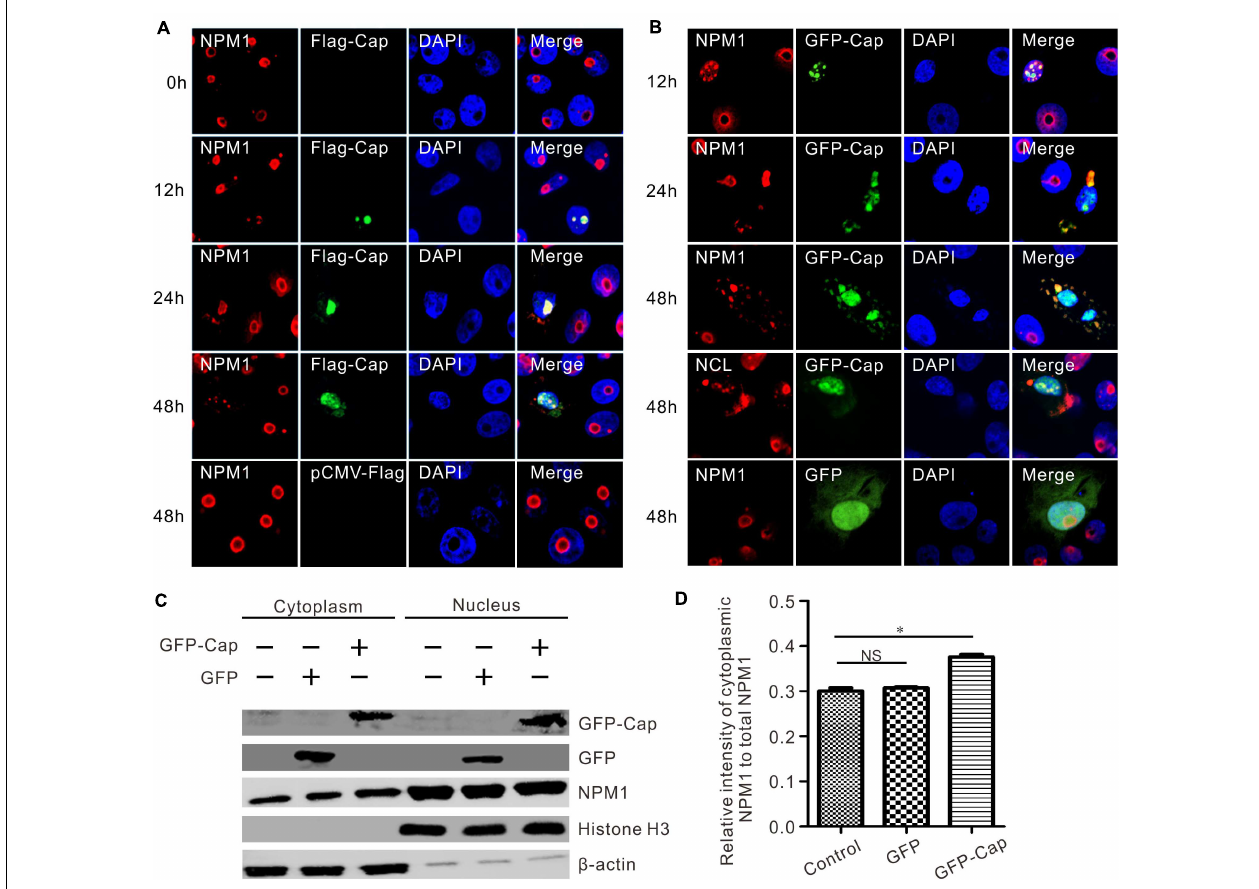
FIGURE 4 | Endogenous colocalization analysis. PCV3 Cap induced the translocation of NPM1 to the cytoplasm from the nucleus. (A,B) PK15 cells were transfected to express FLAG-Cap and GFP-Cap. The cells were incubated with the antibodies corresponding FLAG tag, NPM1, and NCL followed by the Alexa Fluor 568-conjugated secondary antibodies (red). Nuclei were stained with DAPI (blue). (C) The cell nuclear and cytoplasmic extraction was performed after PK15 cells transfected GFP-Cap plasmid. At 48 h post-transfection, the protein samples were prepared and detected using antibodies against GFP and NPM1 by western blot analysis. Histone H3 and β -actin were used as fractionation quality controls. (D) The relative gray intensity of cytoplasmic NPM1 was calculated using ImageJ. Two-tailed Student’s t -test was used for statistical analysis. Each experiment was independently done three times. Data represent by mean ± standard deviation (SD). Asterisks (*) indicate the statistical significance: * P < 0.05; NS: not